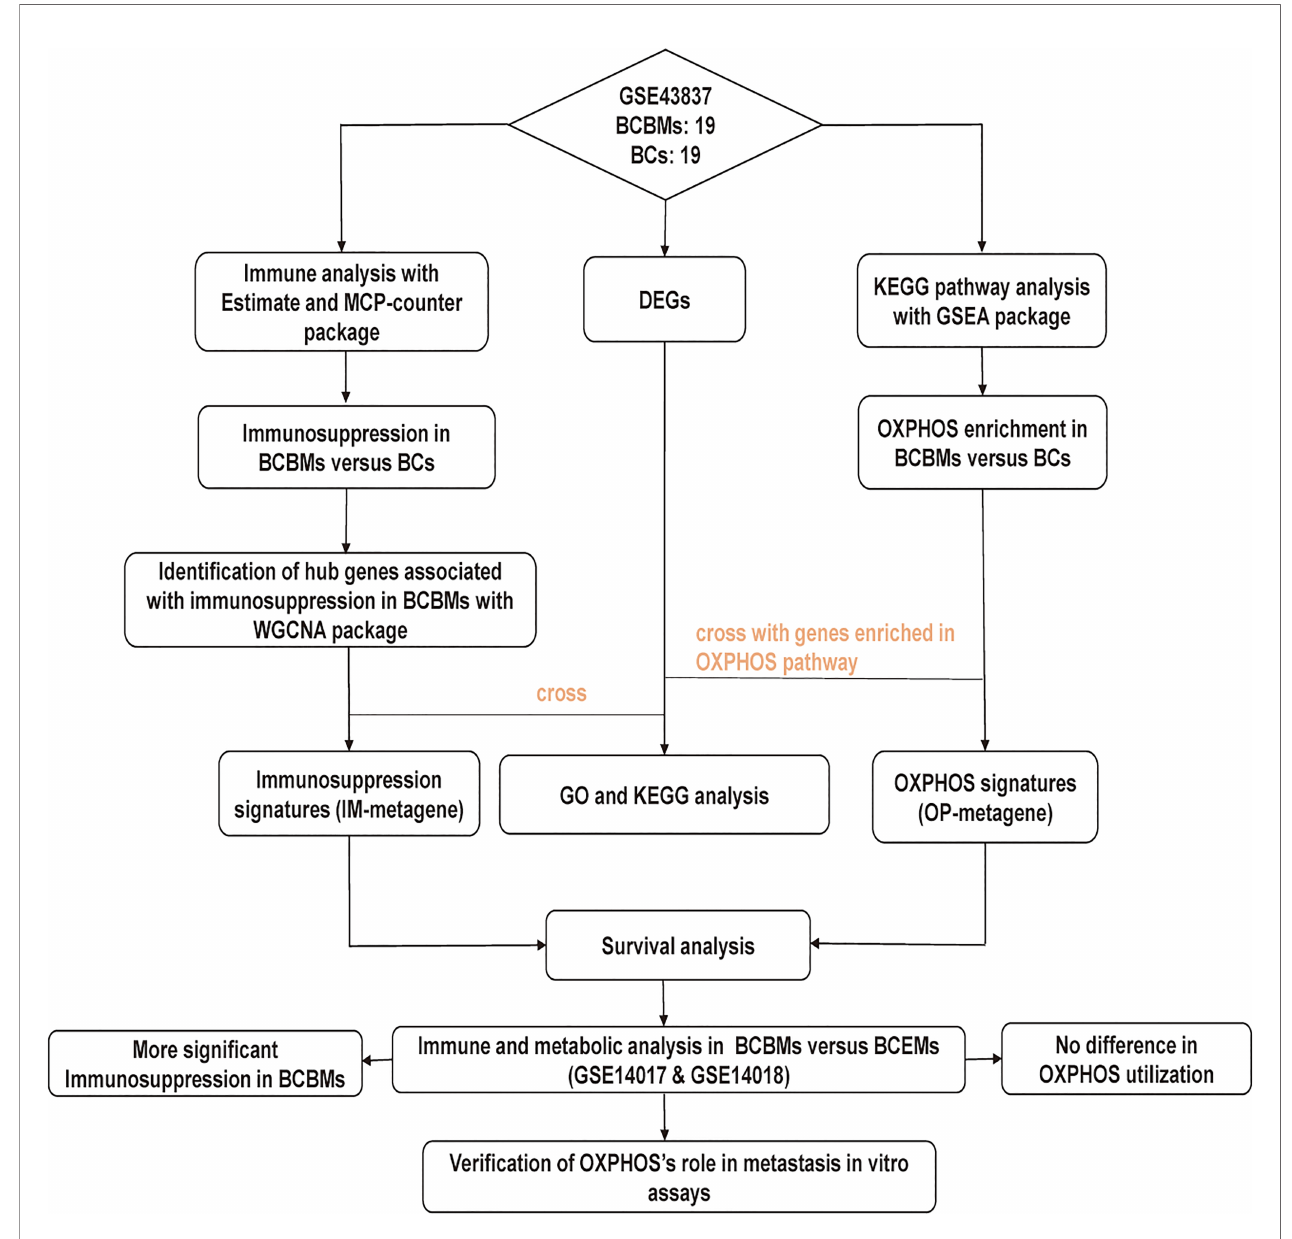
FIGURE 1 | The work fl ow of the study. BCBMs, breast cancer brain metastases; BCs, breast cancers; DEGs, differentially expressed genes; OXPHOS: oxidative phosphorylation; IM-metagene, hub genes related to immune in fi ltration of BCBMs; OP-metagene, hub genes related to oxidative phosphorylation enrichment of BCBMs; GO, gene ontology; KEGG, kyoto encyclopedia of genes and genomes; BCEMs, breast cancer extracranial